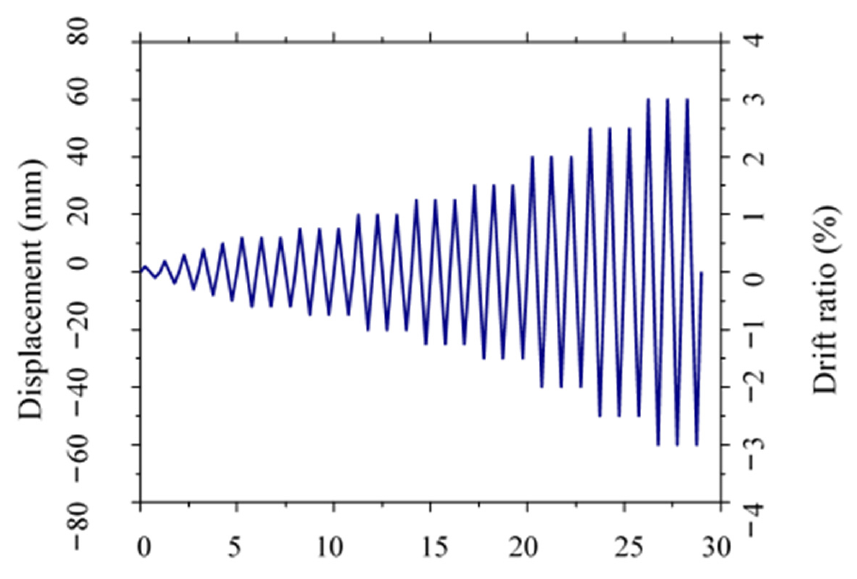
Figure 3. Displacement history of walls.